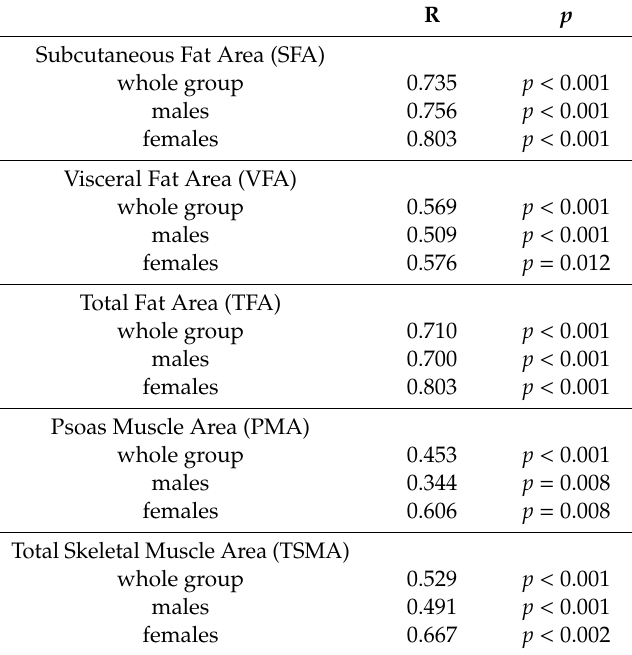
Table 2. Correlations between Body Mass Index and adipose and muscular tissue areas in hepatocellular carcinoma (HCC) patients undergoing liver transplantation.